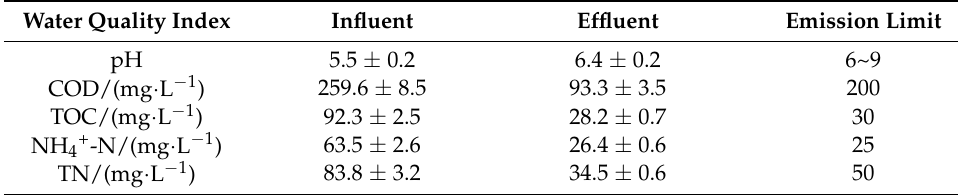
Table 4. Removing effect of acrylic fiber wastewater by Fenton process.